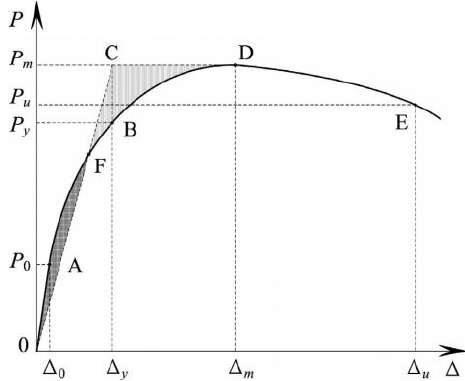
Figure 11. Definition of yield displacement.